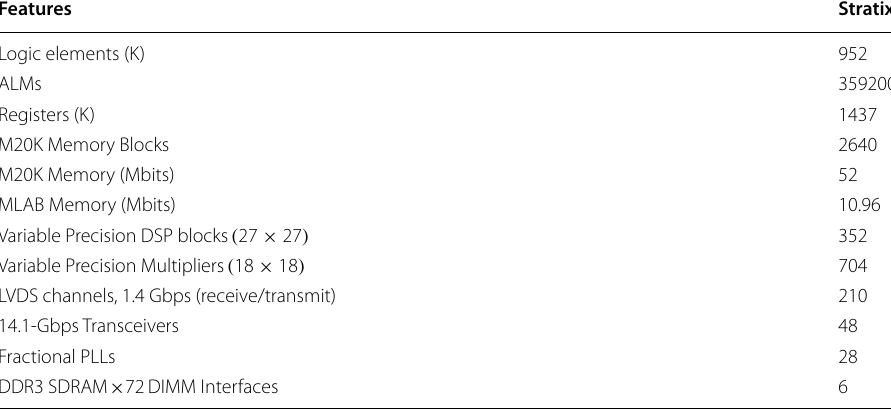
Table 2 FPGA platform (Altera Stratix) specification (from Altera/Intel) Features